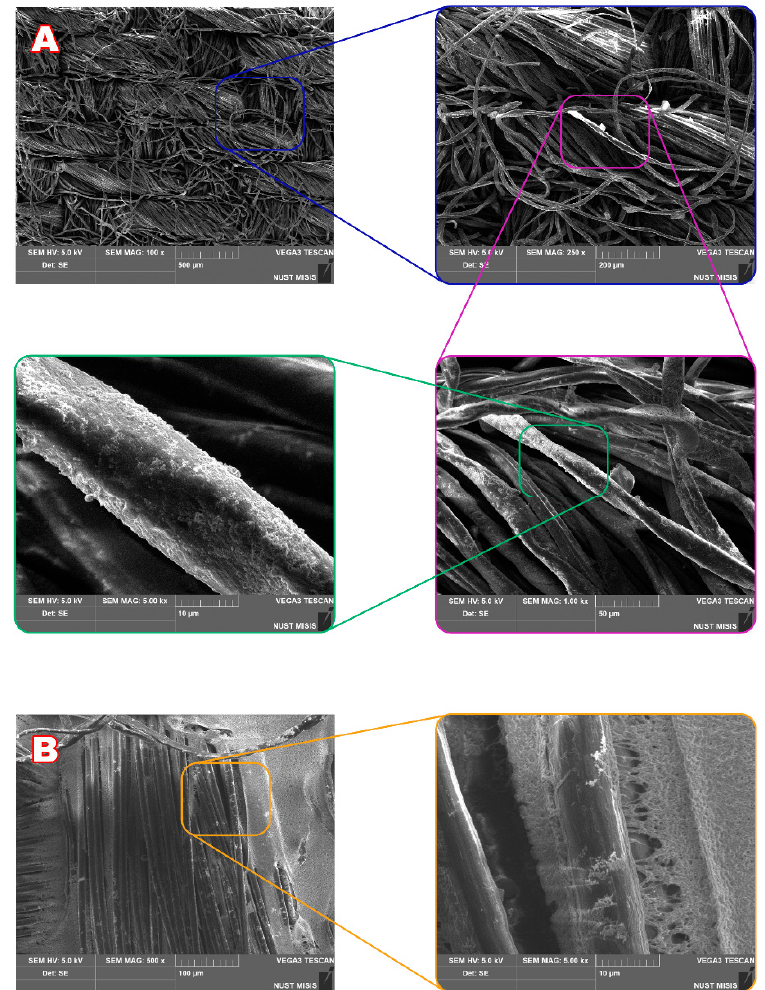
Figure 1. ( A ) SEM images of the front side of the fibrous material after deposition of Ta EtOH nanoparticles. ( B ) SEM images of the back side of the fibrous material after deposition of Ta EtOH nanoparticles. Initial material contained 30% of cotton and 70% of meta polyaramide fiber fabric and is covered by poly(vinylidene difluoride)- co -poly(tetrafluoroethylene) membrane from the back side. Nanoparticles (for example, of Ta) were regularly distributed on the surface of fibrous material (Figure 2), though Ta aggregates tend to be accumulated in close proximity with phosphate and / or carboxy anions (Supplementary Figures S3–S5). Namely, the least quantity of ‘free’ aggregates (i.e., those which were not superimposed with other elements) of Ta EtOH nanoparticles was in the case of oxygen (ca. 20–30%), followed by carbon (ca. 30–40%) and phosphorus (ca. 50%). Co-localization of Ta EtOH nanoparticles with other elements issued was